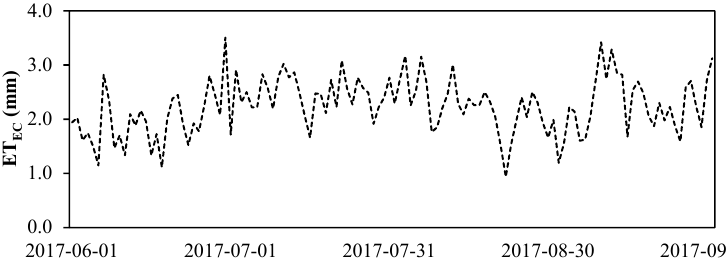
Figure 4. Temporal evolution of daily evapotranspiration measurements (ET EC ) rates using eddy covariance (EC).